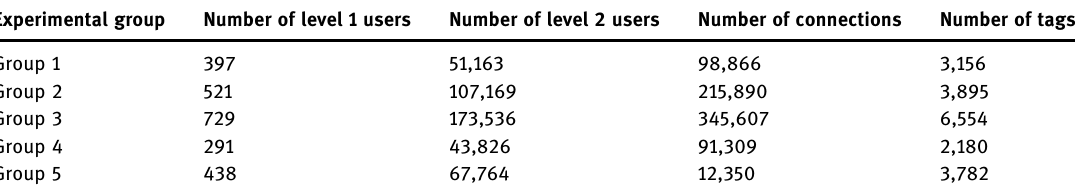
Table 3: Experimental user data set